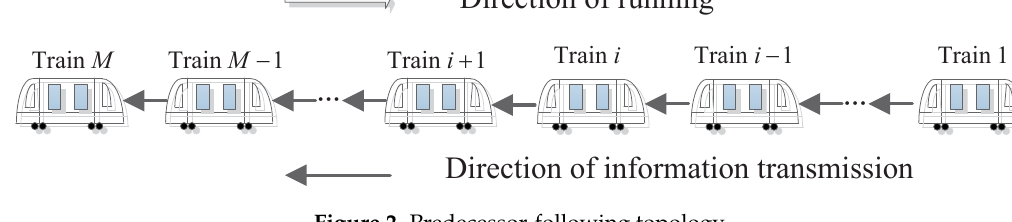
Figure 2. Predecessor-following